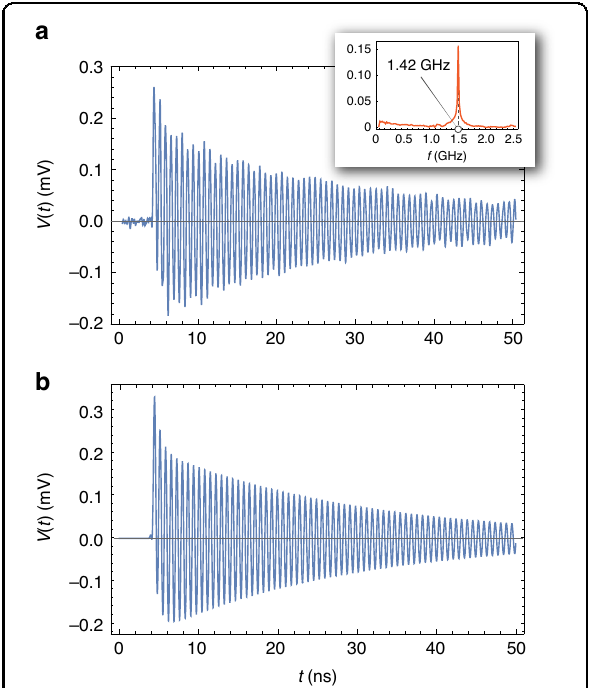
Fig. 4 SPH magnetization-quantum-beat signals. a Experimental SPH magnetization-quantum-beat signal from the photodissociation of HBr at 75 mbar, with a lifetime τ = 25ns and beating frequency f = 1.42GHz, shown by the Fourier transform (inset), and b Theoretical trace calculated using Eq. (6) (see text for